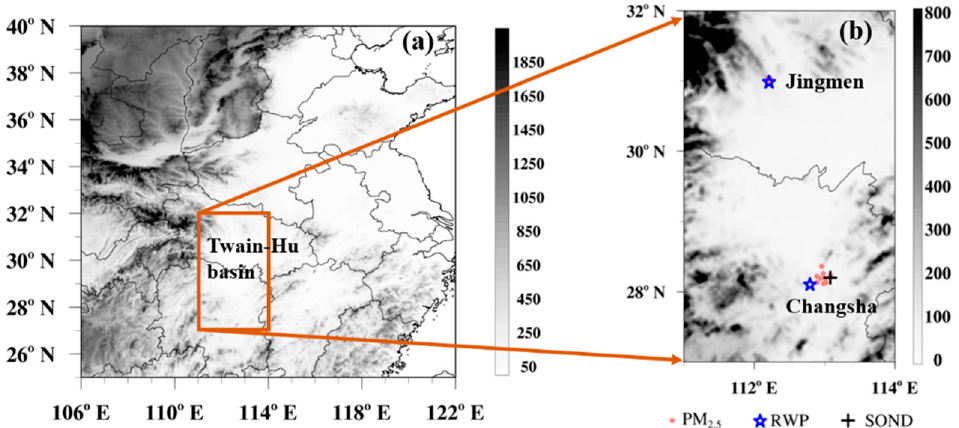
Figure 1. The locations of the ( a ) Twain-Hu basin and ( b ) monitoring sites in Jingmen and Changsha overlaid with topography (color contour, m a.s.l.). The pink dots, blue pentacles, and black pluse are the locations of PM 2.5 , radar wind profiler (RWP), and radiosonde (SOND) sites, respectively.